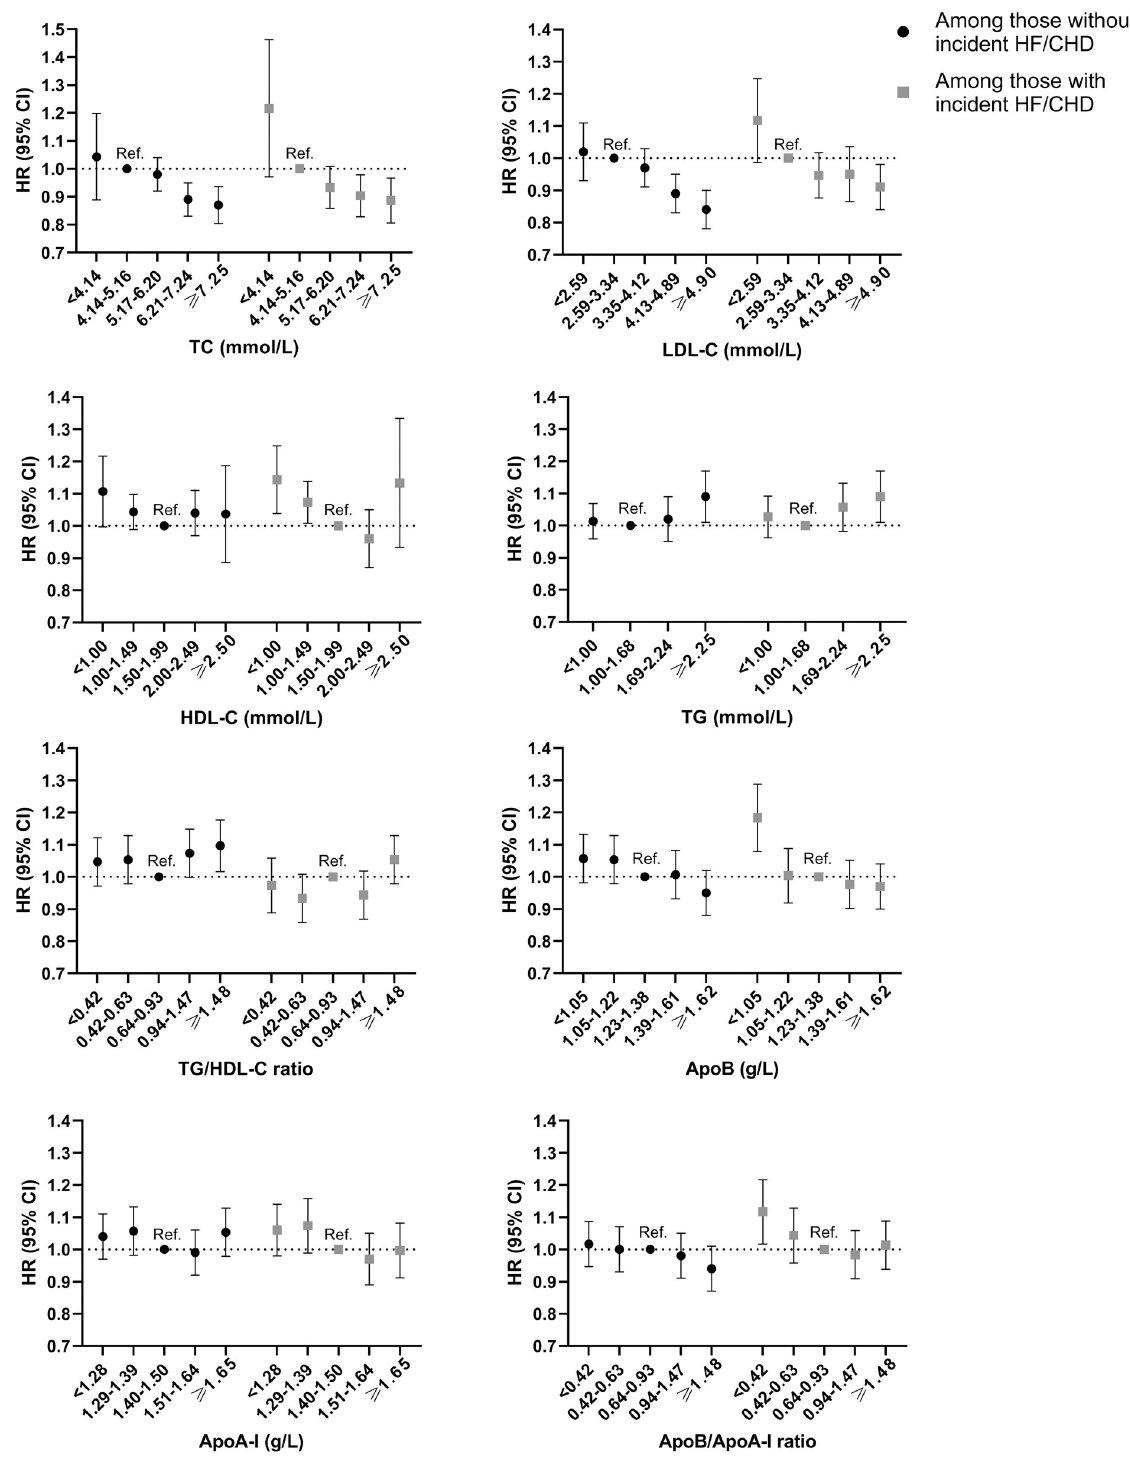
Fig 3. HR (95% CI) for incident AF associated with lipid biomarkers in categories, stratified by incident HF/CHD. All models are adjusted for age, sex, and SES at baseline. AF, atrial fibrillation; ApoA-I, apolipoprotein A-I; ApoB, apolipoprotein B; CHD, coronary heart disease; CI, confidence interval; HDL-C, high-density lipoprotein cholesterol; HF, heart failure; HR, hazard ratio; LDL-C, low-density lipoprotein cholesterol; SES, socioeconomic status; TC, total cholesterol; TG, triglycerides.